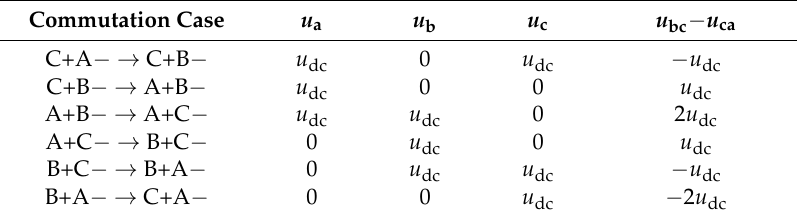
Table 2. Voltage spike values in 360-degree electrical